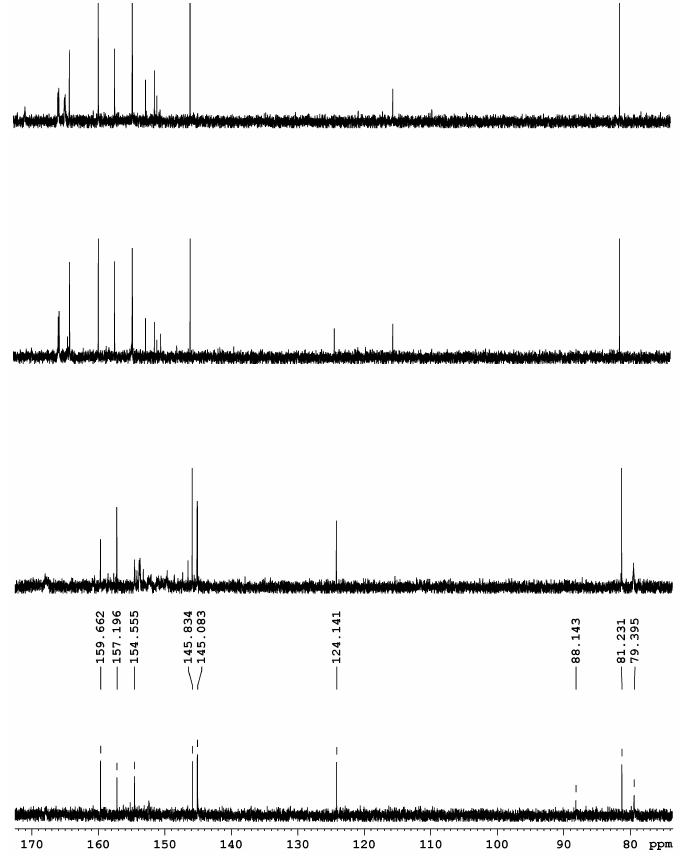
Figure 2. 13 C NMR spectra of mixed 22 and 22 / (from bottom to top ): the initial one was taken shortly after dissolution and after 2 h, 4 h, and 12